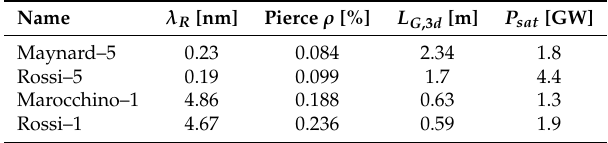
Table 4. FEL semi-analytical results based on the best slice parameters of Table 3.